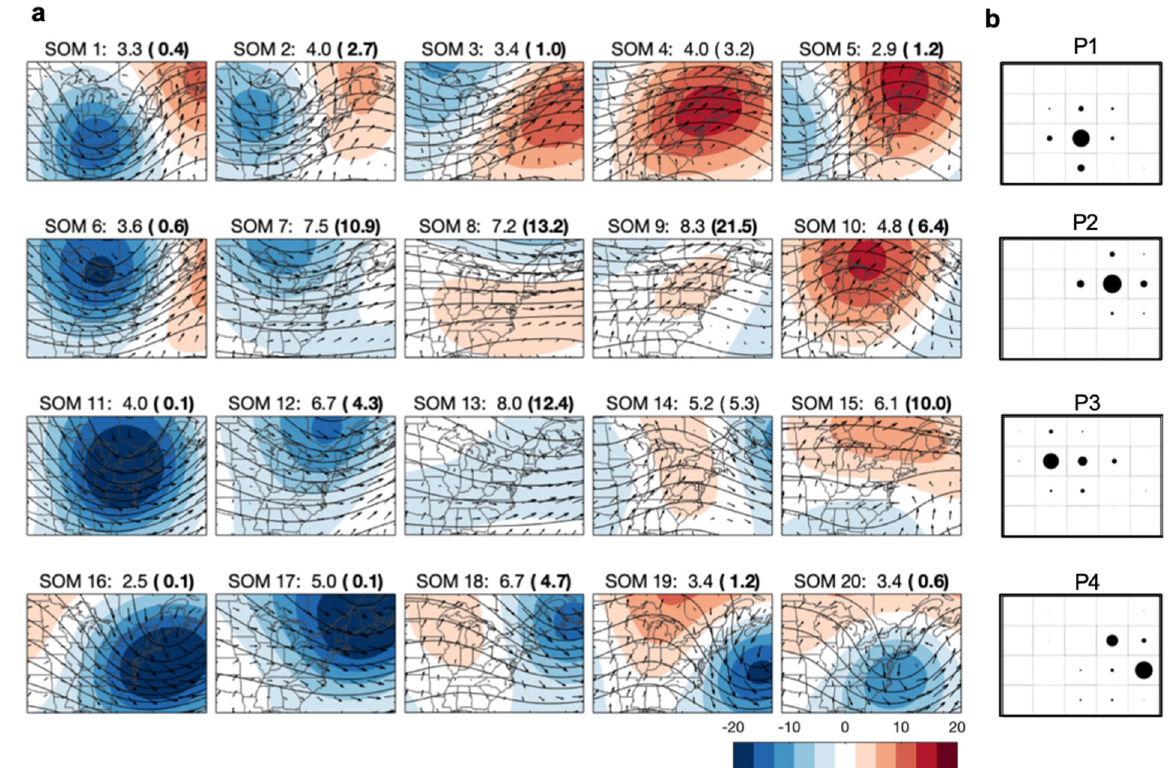
Fig. 4 Self-organizing map of circulation patterns. a The results of SOM analysis on the same fi elds as used for k-means typing, but for all days 1980 – 2018, separated into a 4 × 5 pattern space, with the text above each panel showing the SOM number, the percent of all days assigned to the SOM, and the percent of regional heat wave days that belong to the SOM (in parenthesis, with the value in bold if signi fi cantly higher or lower than expected based on random sampling). b The relative frequency (proportional to dot size) of P1, P2, P3, and P4 days assigned to each